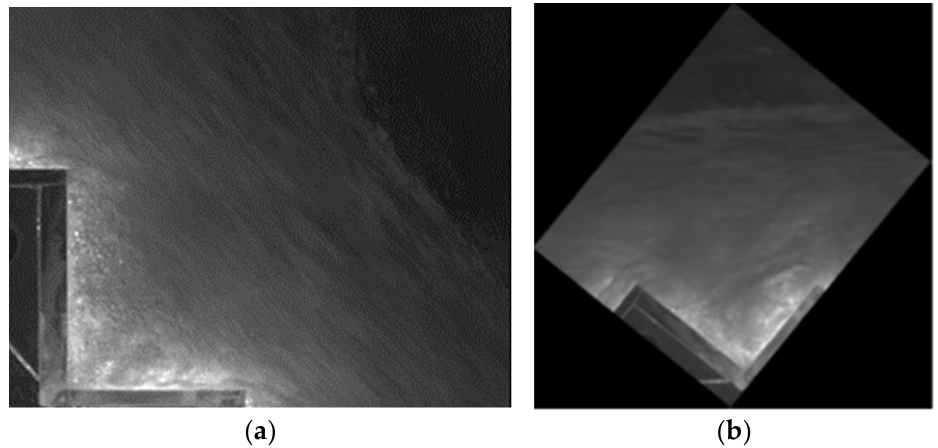
Figure 5. Image corresponding to L / L t = 0.49 and d c / h = 2.38: ( a ) Original frame; ( b ) Rotated frame 51.3 ◦ counterclockwise.